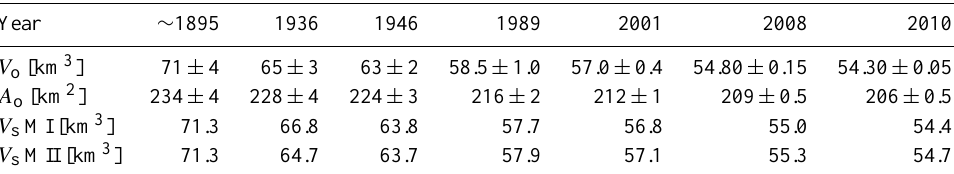
Table 3. Volume ( V ) and area ( A ) of Hoffellsjökull. V o and A o are observed, V s MI is simulated with method MI ( A =6.8 × 10 − 15 s − 1 kPa − 3 ) implicitly including basal sliding, V s MII is simulated with method MII ( A =4.6 × 10 − 15 s − 1 kPa − 3 and C =10 × 10 − 15 ma − 1 Pa − 3 ). All volumes correspond to autumn, where the 2001 volume, measured in the spring, has been corrected with the summer balance in Table 1. Here, the error of the corrected 2001 map is estimated to be within 2m. The errors shown are from the surface maps, calculated using the standard error formula (this error is independent between each observed year). In addition to this error, there is an uncertainty of < 3km 3 (same for all years), due to errors in the bedrock map. Those two volume errors need to be displayed and interpreted independently due to their different nature.